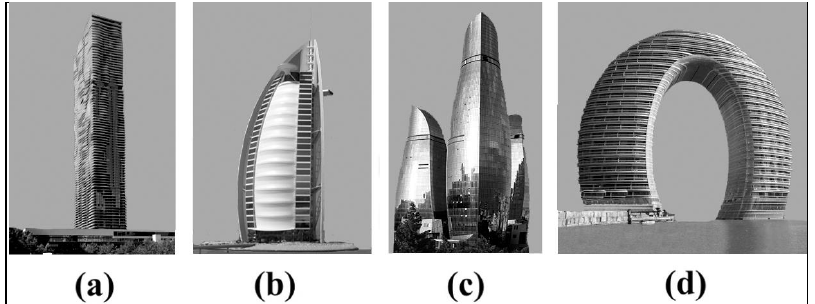
Figure 4. Free form type of high-rise buildings: ( a ) Aqua Tower (Chicago, core and outrigger system), ( b ) Burj Al Arab (Dubai, composite frame system with diagonal steel trusses), ( c ) Flame Towers (Baku, frame tube system) and ( d ) Sheraton Huzhou Hot Spring Resort (Huzhou, core system), figure by authors.